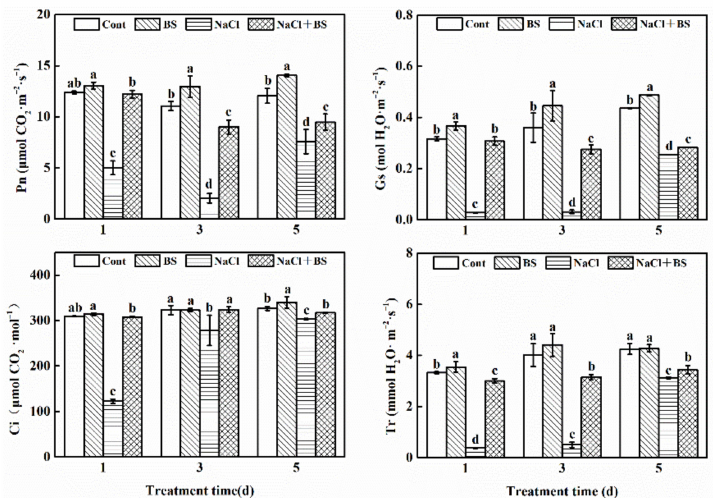
Figure 4. Effect of B. cereus on photosynthetic performance of cucumber seedlings under salt stress. Bars represent standard errors. Different letters indicate a significant difference in the same parameter between treatments at p <